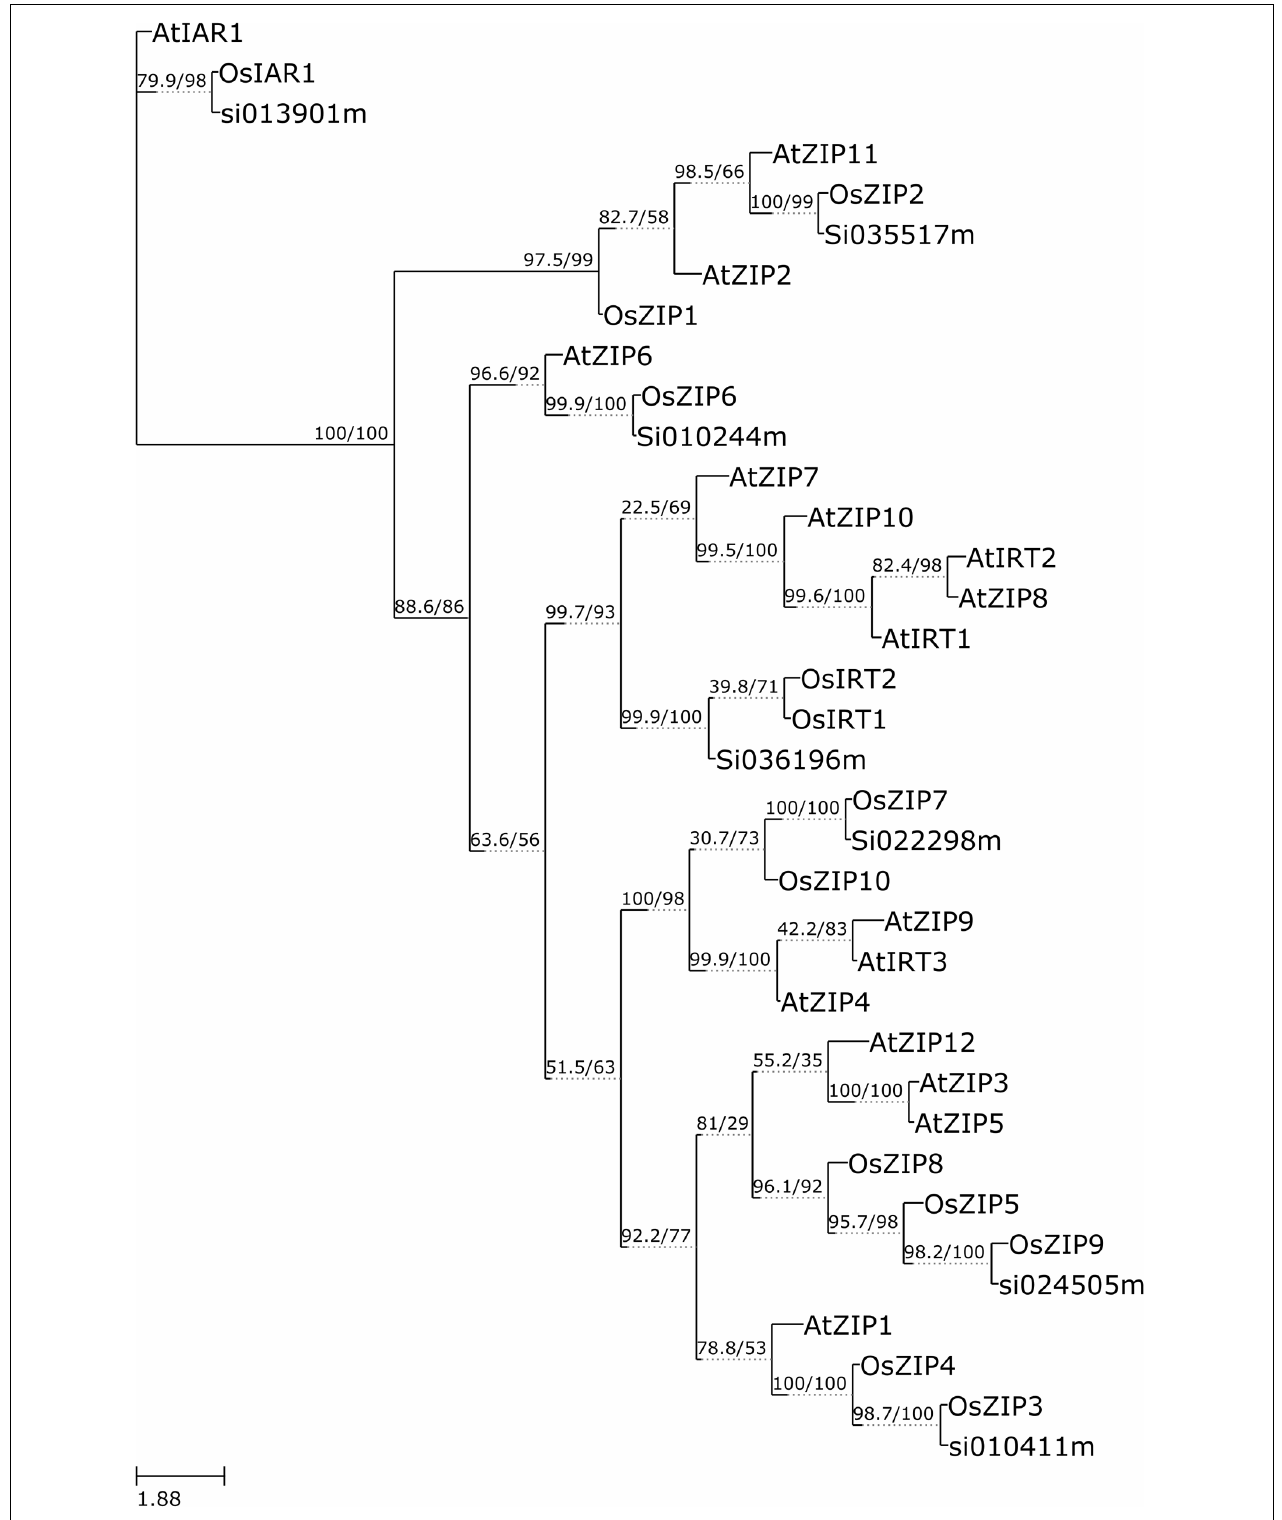
FIGURE 3 | Molecular Phylogenetic analysis by Maximum Likelihood method. The evolutionary history was inferred by using the Maximum Likelihood method based on W-IQ-TREE. The bootstrap consensus tree inferred from 1000 replicates is taken to represent the evolutionary history of the taxa analyzed (Felsenstein, 1985). The analysis involved 36 amino acid